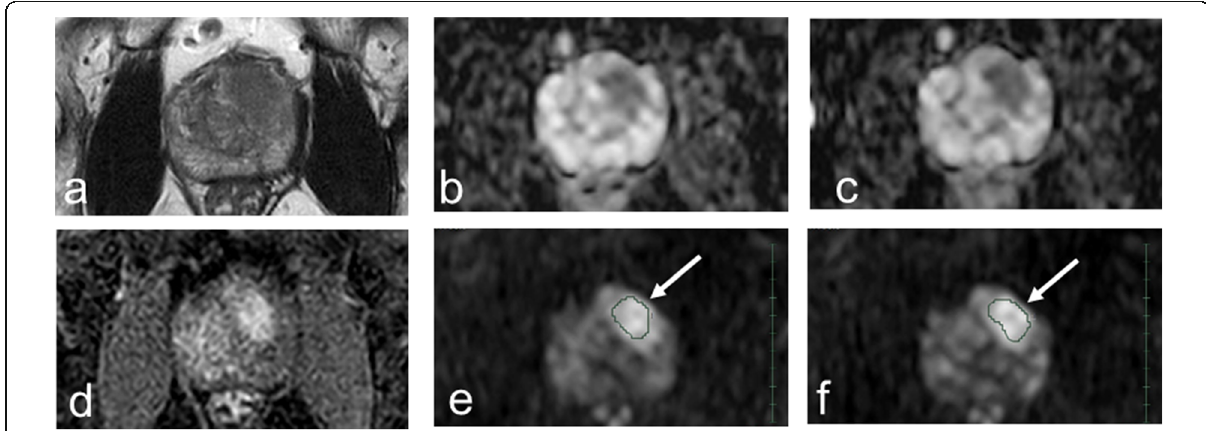
Fig. 3 Multiparametric magnetic resonance imaging of the case (61 years, transition zone cancer, GG of 2, PI-RADS of 5, T2cN0M0). a Axial T2- weighted image (repetition time of 4,000 ms and echo time of 80 ms). b First axial apparent diffusion coefficient (ADC) map (100, 1,000). c Second axial ADC map (100, 1,000). d Dynamic contrast-enhanced T1-weighted image. e First DWI 1,500. f Second DWI 1,500. Arrows